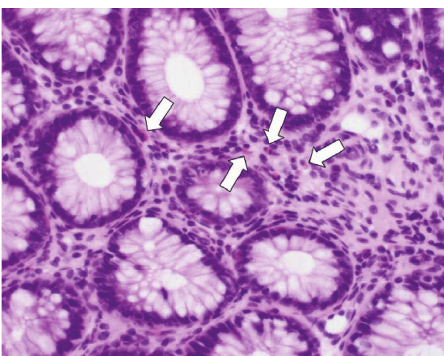
Figure 5: The pathology of a biopsy sample taken from the descending colon wall showed eosinophilic infiltration (arrows) (hematoxylin and eosin staining, ×